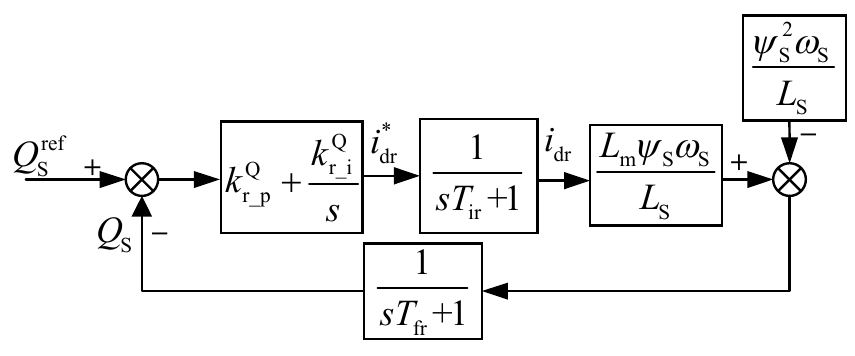
Figure 6. Reactive power control loop of the DFIG.